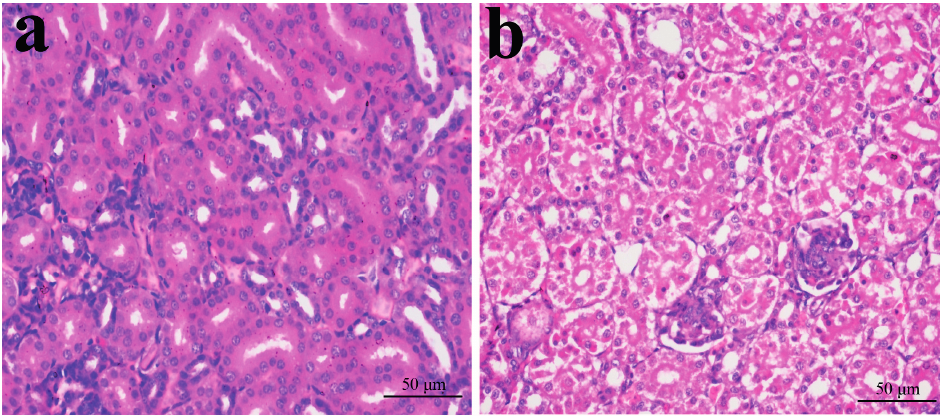
Figure 2. Histopathological changes in the kidney at 28 days of age. ( a ) Control group. No changes are observed (H·E × 400); ( b ) 300 mg/kg group. Tubular cells show granular degeneration (H·E × 400); ( c ) 600 mg/kg group. Tubular cells show obvious granular and vacuolar degeneration. Also, few necrotic tubular cells and apoptotic tubular cells are observed (H·E × 400); and ( d ) 900 mg/kg group. Tubular cells show marked granular and vacuolar degeneration. Also, some necrotic tubular cells ( ▲ ) and apoptotic tubular cells ( ↑ ) are observed (H·E ×